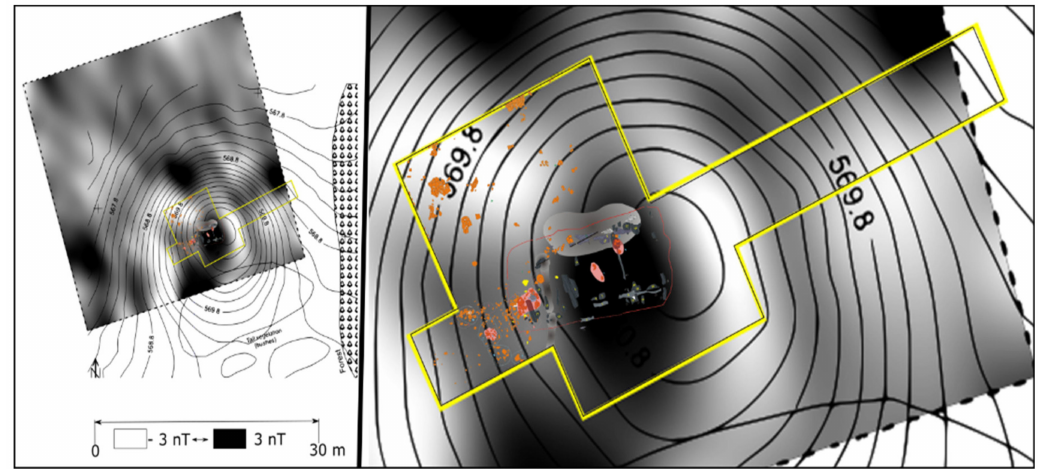
Figure 14. The archaeological excavation plan presented in Diaconescu 2020 [24] overlayed on the magnetic map (left). On the right, a detailed view of the excavated archaeological features matching the magnetic anomaly M1, located in the central part of the mound, is